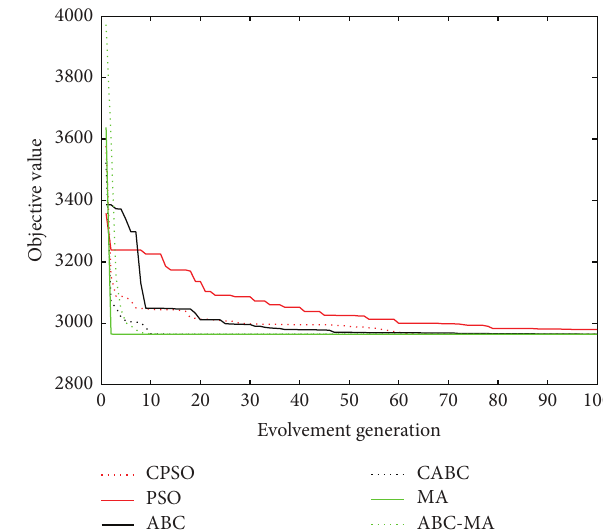
Figure 14: The convergence curve of the heart data.